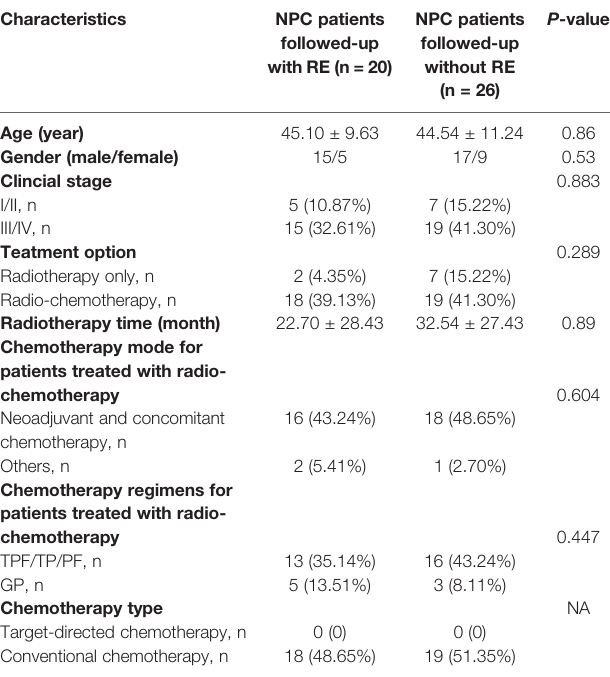
TABLE 1 | Demographic and clinical characteristics.